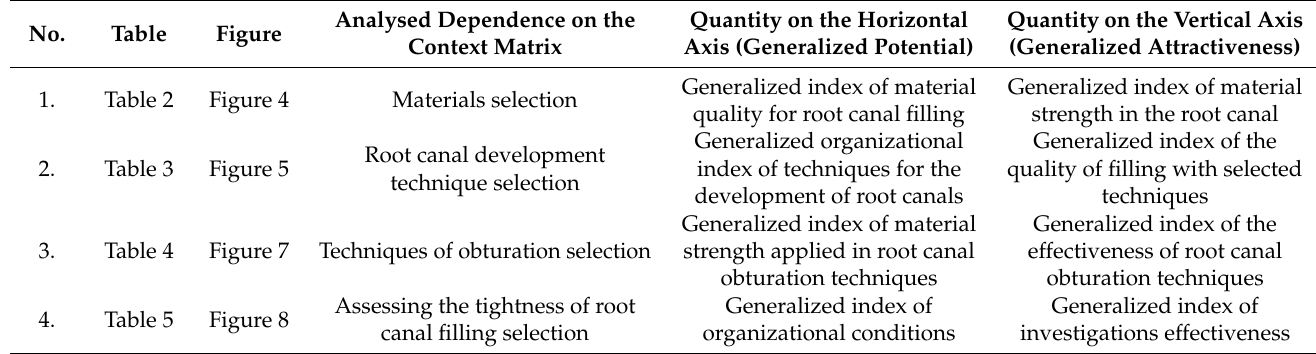
Quantity on the Vertical Axis (Generalized Attractiveness) Generalized index of material strength in the root canal Generalized index of the quality of filling with selected techniques Generalized index of the effectiveness of root canal obturation techniques Generalized index of investigations effectiveness